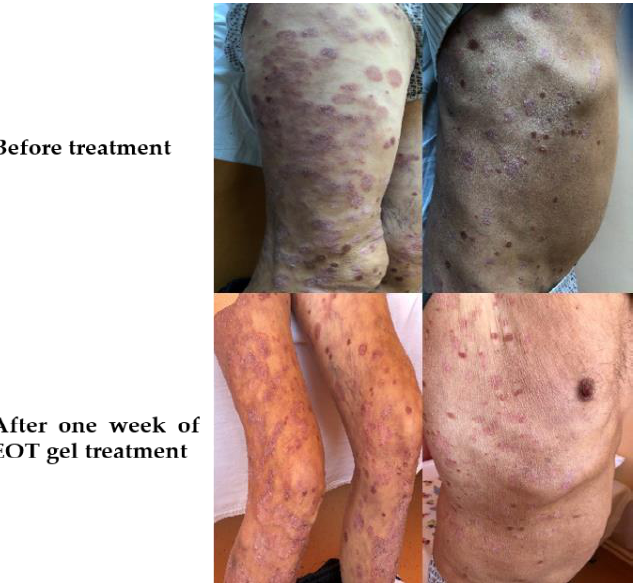
Figure 10. Clinical aspects of Psoriasis vulgaris treated with gel formulation of Ocimum basilicum and Trifolium pratense extract mixture.